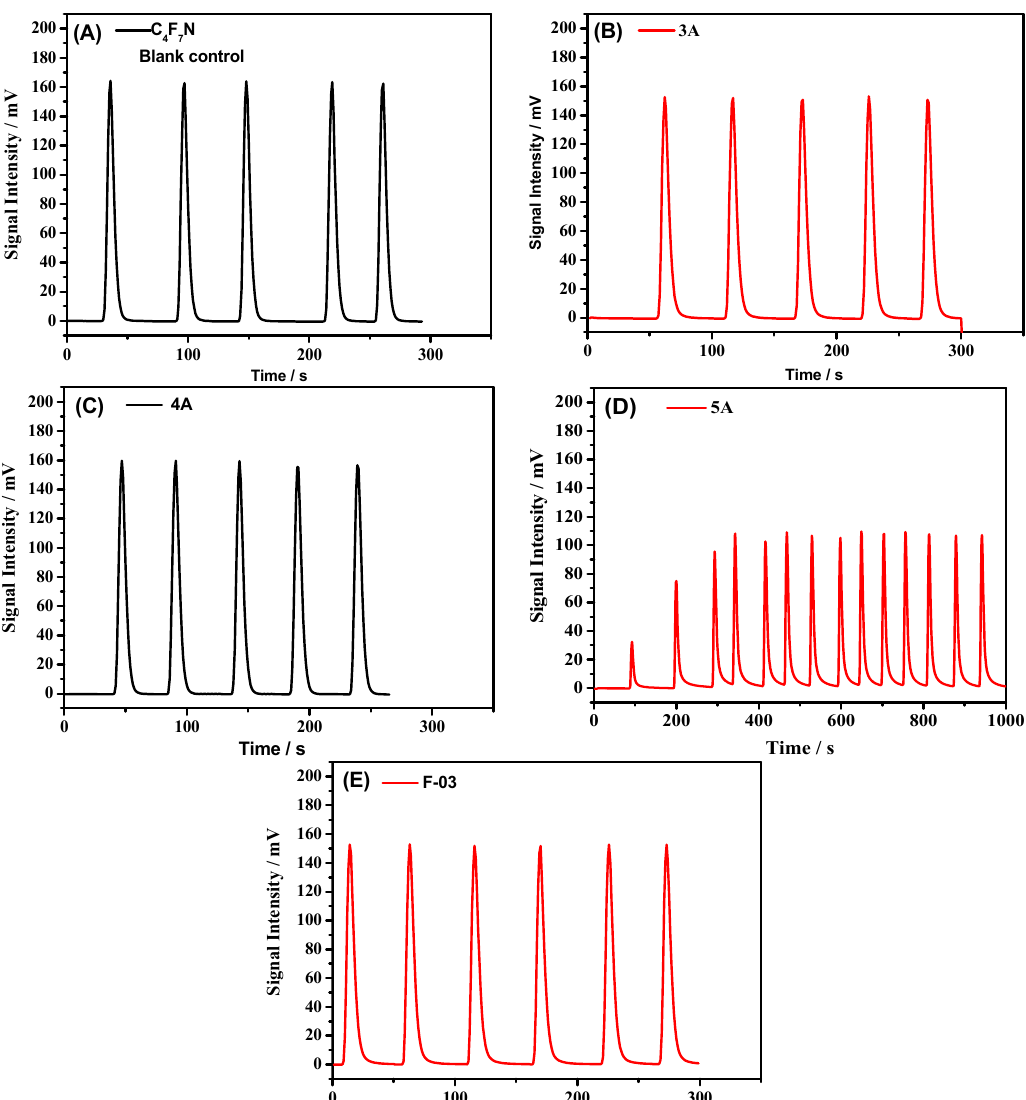
Figure 2. Adsorption performance of adsorbent materials with C 4 F 7 N tested with pulse adsorption, ( A ) Blank control, ( B ) 3A, ( C ) 4A, ( D ) 5A molecular sieve, ( E )